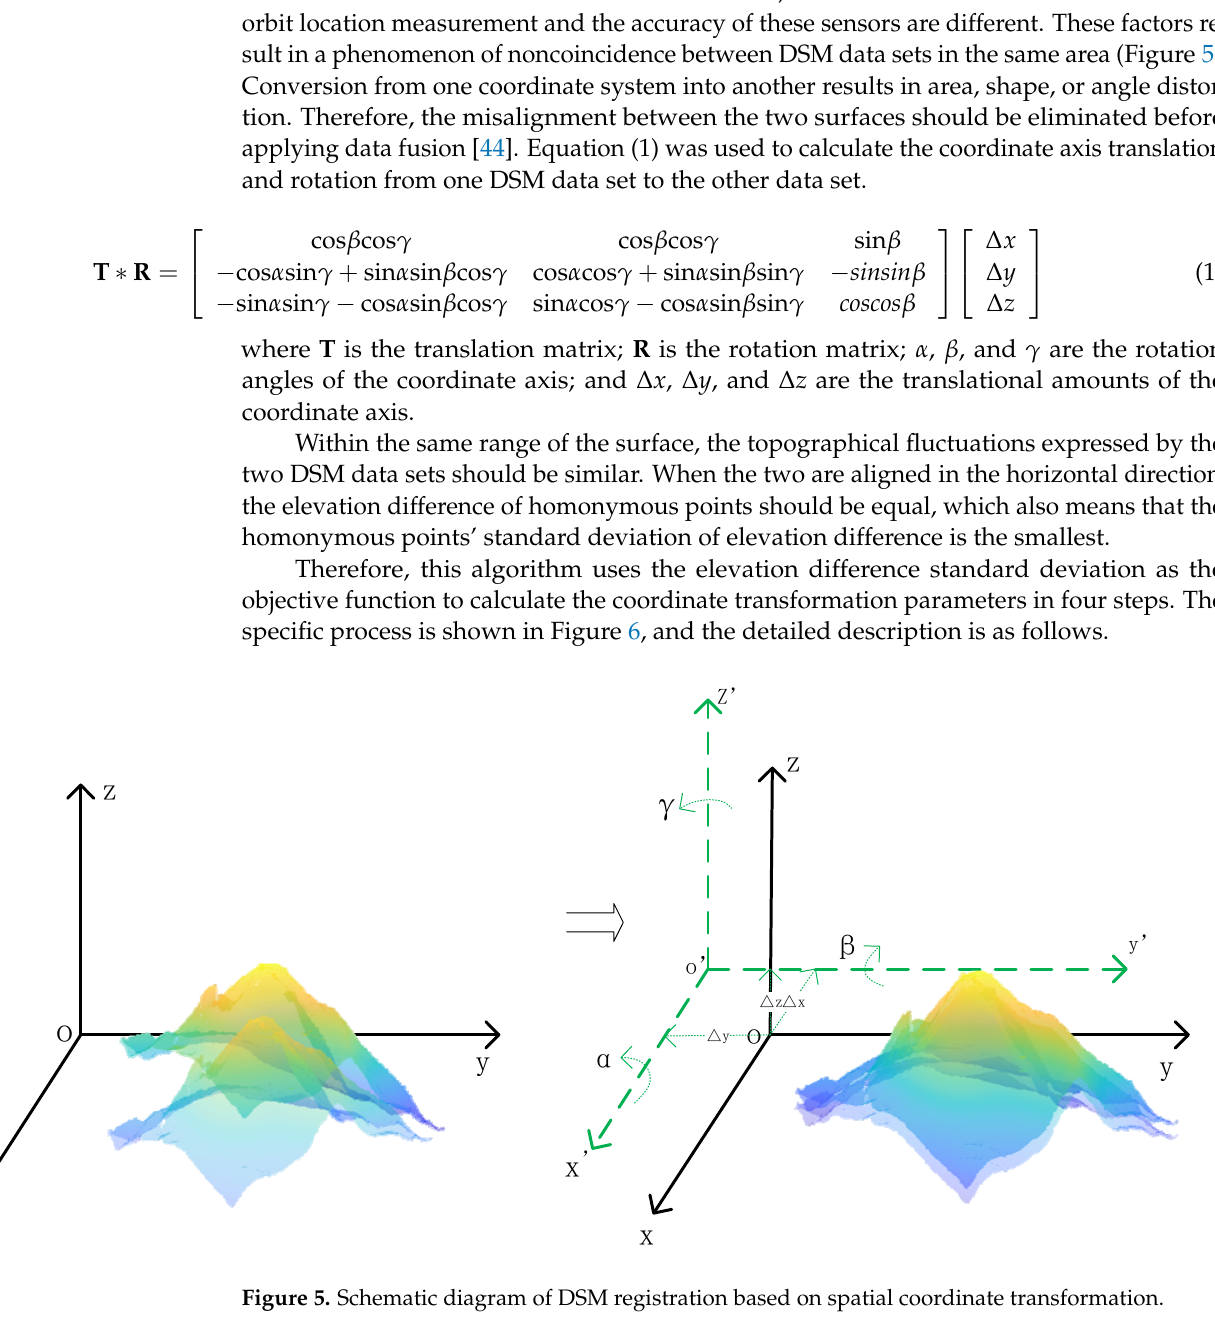
Figure 5. Schematic diagram of DSM registration based on spatial coordinate transformation.